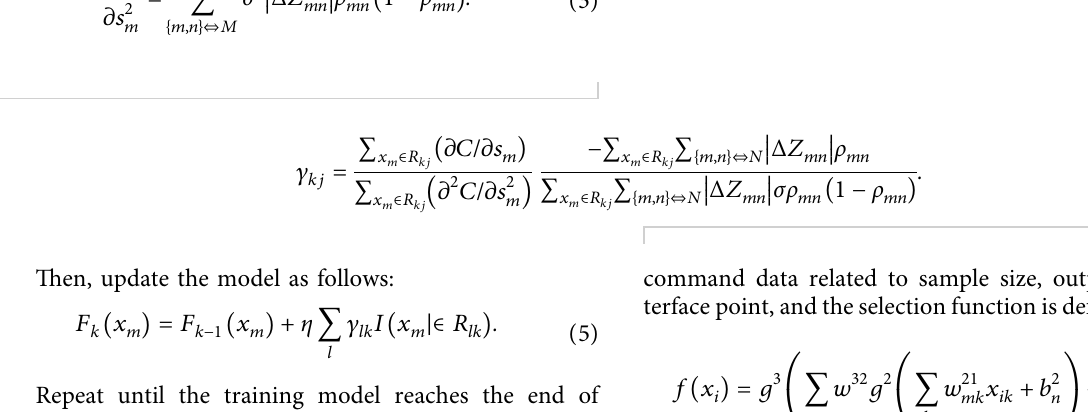
Figure 4: Data storage